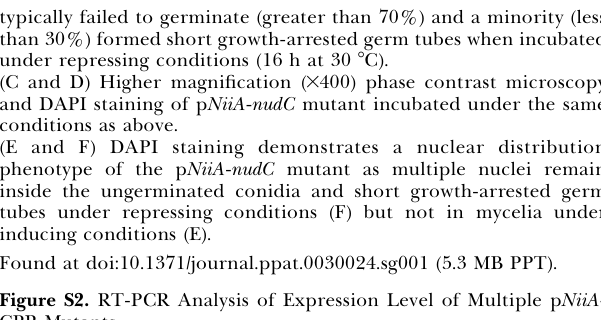
Figure S2. RT-PCR Analysis of Expression Level of Multiple p NiiA - CPR Mutants p NiiA -CPR mutants were grown in AMM plus nitrate (In) or AMM plus ammonium (Re) at 37 8 C for 20 h, and total RNA was extracted and normalized. To monitor and ensure even sample loading, RT- PCRs for the ACT1 transcript were also performed using identical samples (unpublished data). Standard PCR was also performed to confirm that there is no detectable genomic-DNA contamination (unpublished data). Figure S3. Normal Hyphal Growth of p NiiA -CPR Mutants under Inducing Conditions To compare terminal phenotypes characterized in Figure 4, p NiiA - CPR mutants of GFA1, TUB1, SEC31, SLY1, ERG10, HEM15, PRI1, and FKS1 were grown on AMM plus nitrate (inducing conditions) at 30 8 C for 2 d. Micrographs were taken under a microscope at a magnification of approximately 3 80. Found at doi:10.1371/journal.ppat.0030024.sg003 (299 KB PPT). Table S1. Primers Used for p NiiA Cassette Construction, Northern Blot, and RT-PCR Table S2. Forward and Reverse Primers and Probes Used in Real- Time RT-PCR Found at doi:10.1371/journal.ppat.0030024.st002 (26 KB